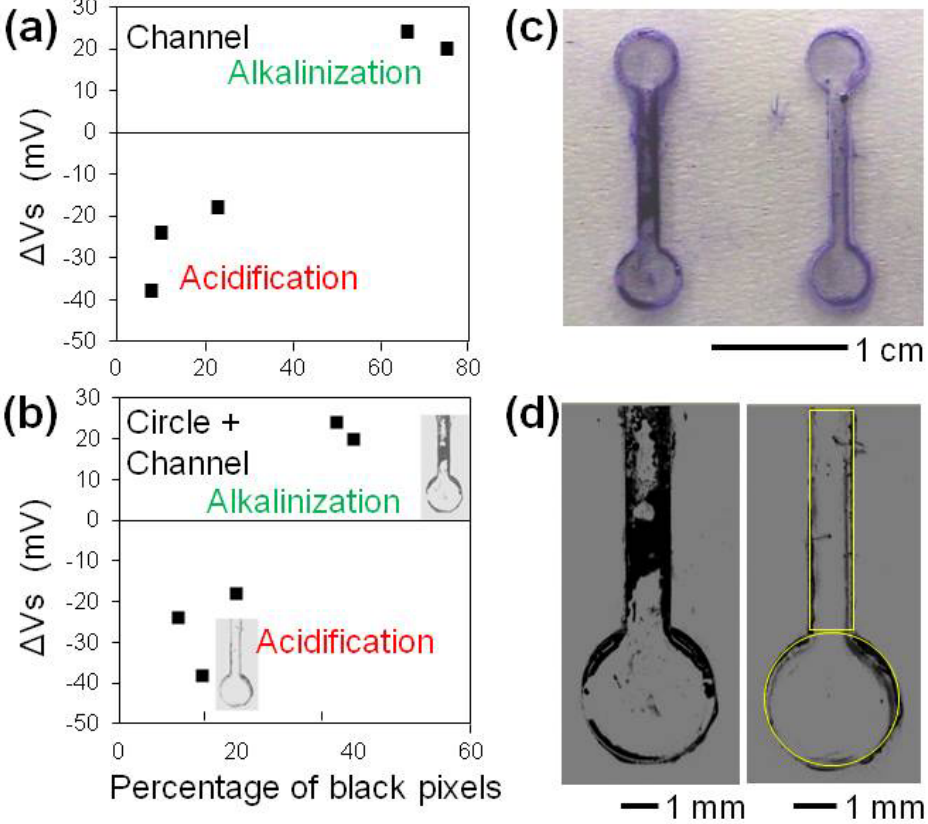
Figure 4. ( a , b ) Relationship between the percentage of stained biofilm coverage in the microfluidic channels and pH of the medium containing M. luteus measured using ISFET. Horizontal axes in (a) and (b) are percent coverage in channel regions and in circle and channel regions, respectively. Voltages in the vertical axes are the difference between those of M. luteus suspensions and medium ( Δ V ). ( c ) Images of M. luteus biofilms formed in the s microfluidic channels under alkalinized (left) and acidified (right) conditions. The biofilms were stained with crystal violet. The width of the microfluidic channel was 1 mm. ( d ) Grayscale microscopic images of the stained biofilms at the bottom of the microfluidic channels. The left and right images in (c) correspond to those in (d), respectively. Yellow rectangles and circles indicate ROIs in which the percent coverage of the biofilms was